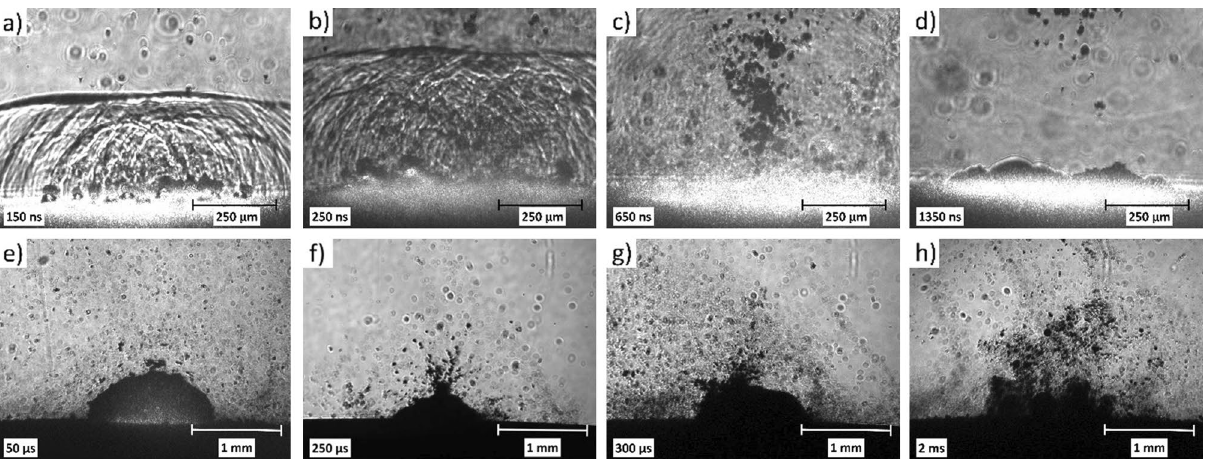
Figure 11. Fast photography images of PLAL (λ = 532 nm, F = 6 J/cm 2 ) of meloxicam in distilled water. (a)–(c) Formation and propagation of the wave front; (d)–(g) Rebounding dynamics of the cavitation bubble with increasing particle ejection; (h) Disintegration of the cavitation bubble and particle release/dispersion in the